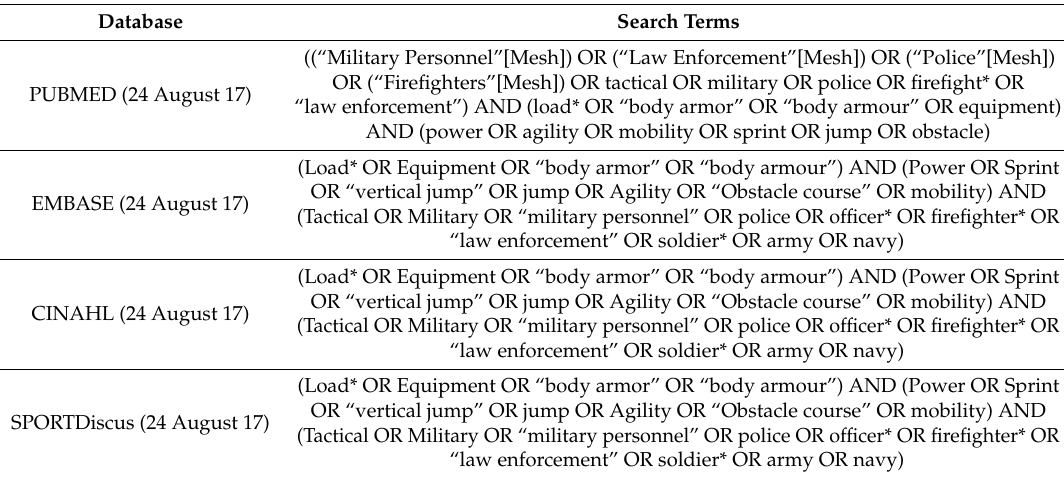
Table 1. Databases and search terms used during literature search.